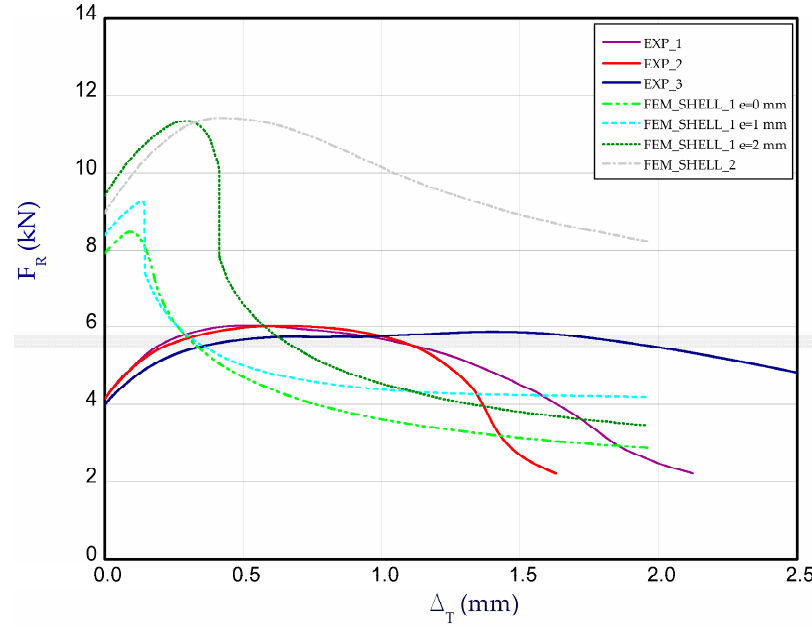
Figure 20. The compression curves of column at 175 °C.